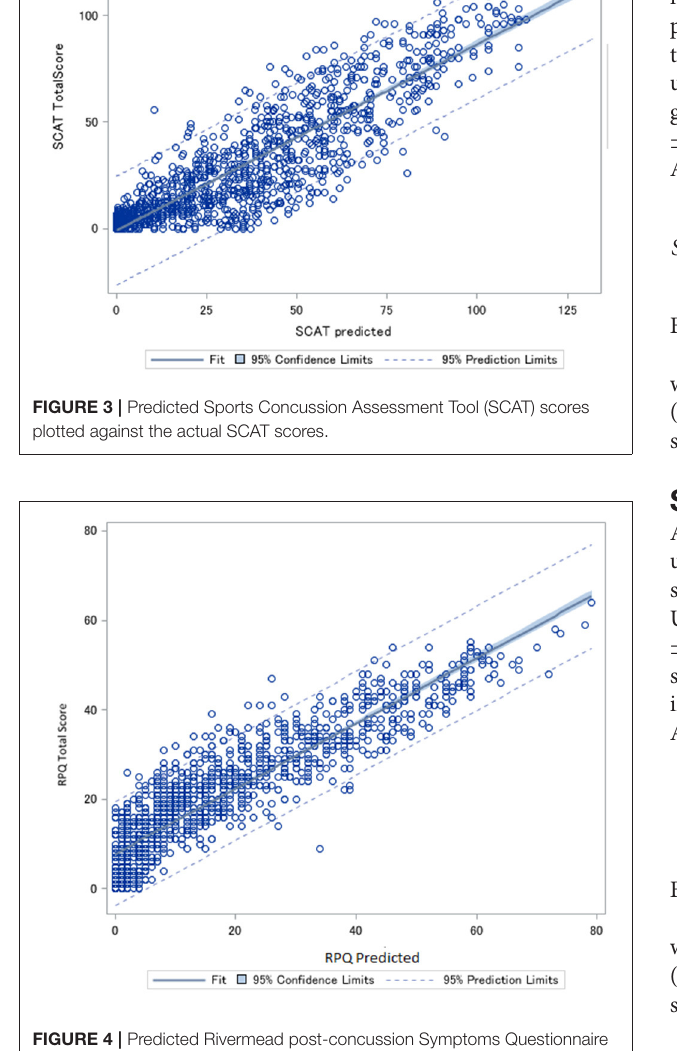
Sleep domain group. The Sleep domain group was removed on the second step-wise step. No other factors were